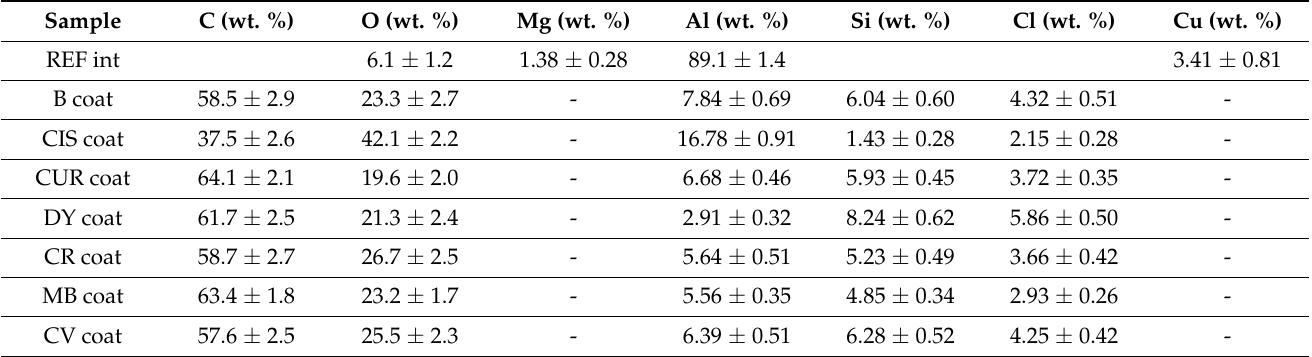
Figure 7. SEM images of a crosssection of samples AL, REF, B, CIS, CUR, DY, CR, MB, and CV. The coatings have remained unaltered during the accelerated salt weathering and are visible in the SEM images. Their thicknesses have remained constant and in good agreement with the values obtained from the VIS reflectance measurements (Table 2). EDX analyses of the images show a composition similar to that of the nominal AA2024 alloy for the inside of the REF sample, where the O content increases when approaching the outer crust (Table 3). Table 3. EDX analysis of the crosssection of the weathered